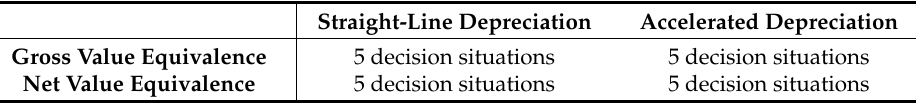
Table 6. Specification of the decision